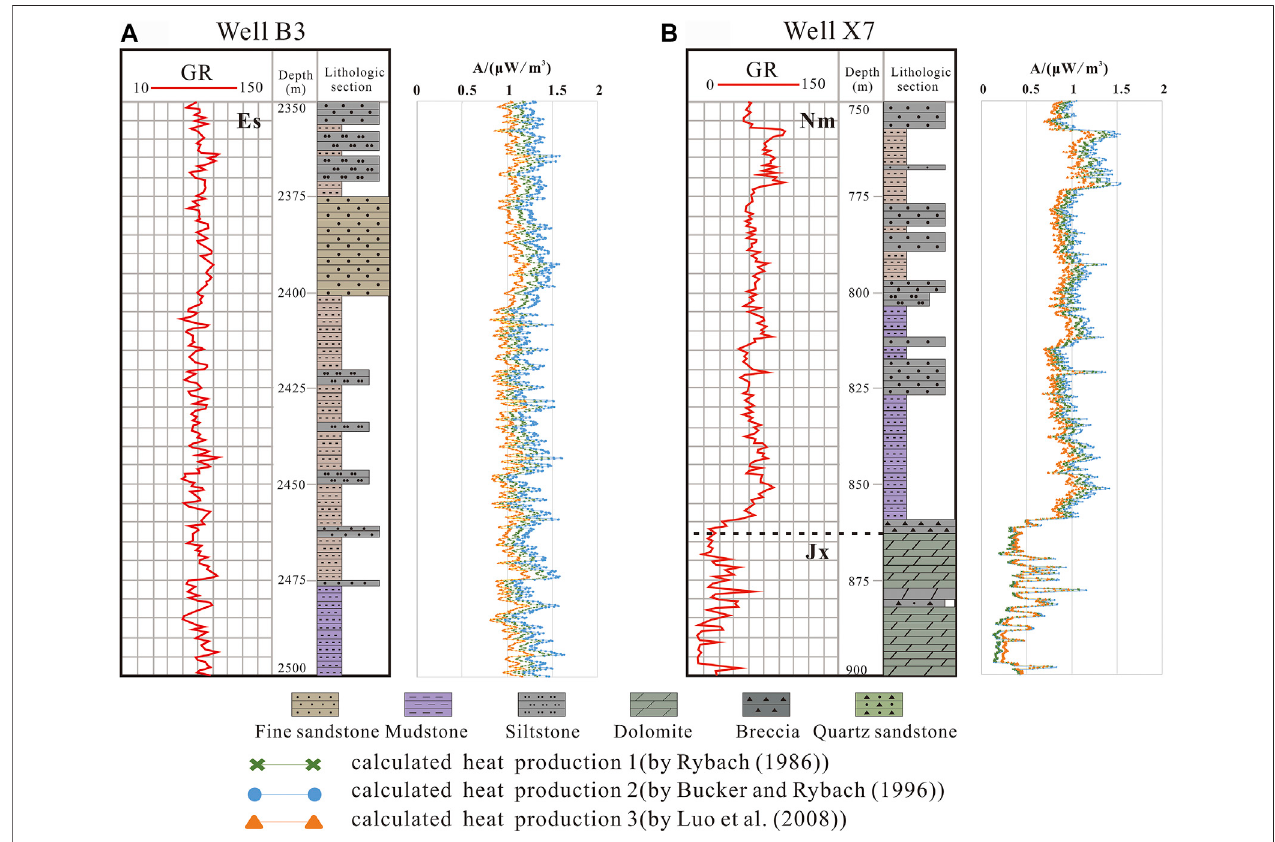
FIGURE 2 | The curves of GR logging and calculated heat production of (A) Wells B3 and (B) Well X7. The green line in Figure 2 is the heat production of the sedimentary layer calculated according to Eq. 1 byRybach (1986); the blue line isthe heatproduction of sedimentary layer calculated according to Eq. 2 byBucker and Rybach (1996); the orange line is the heat production of sedimentary layer calculated according to Eq. 3 by Luo et al. (2008).